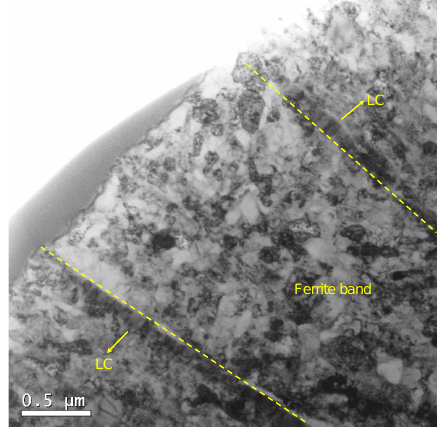
Figure 6. Unpublished TEM image of a lamella prepared by a focused ion beam of a LAB consisting of a ferrite band and